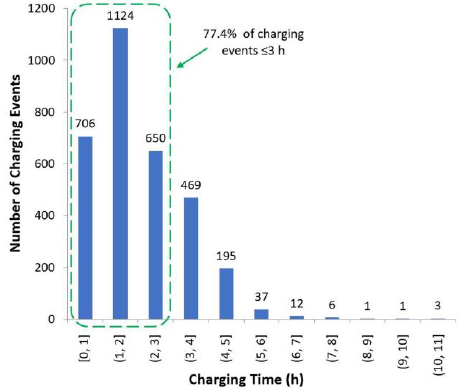
Figure 1. Histogram of the charging time in each charging event.